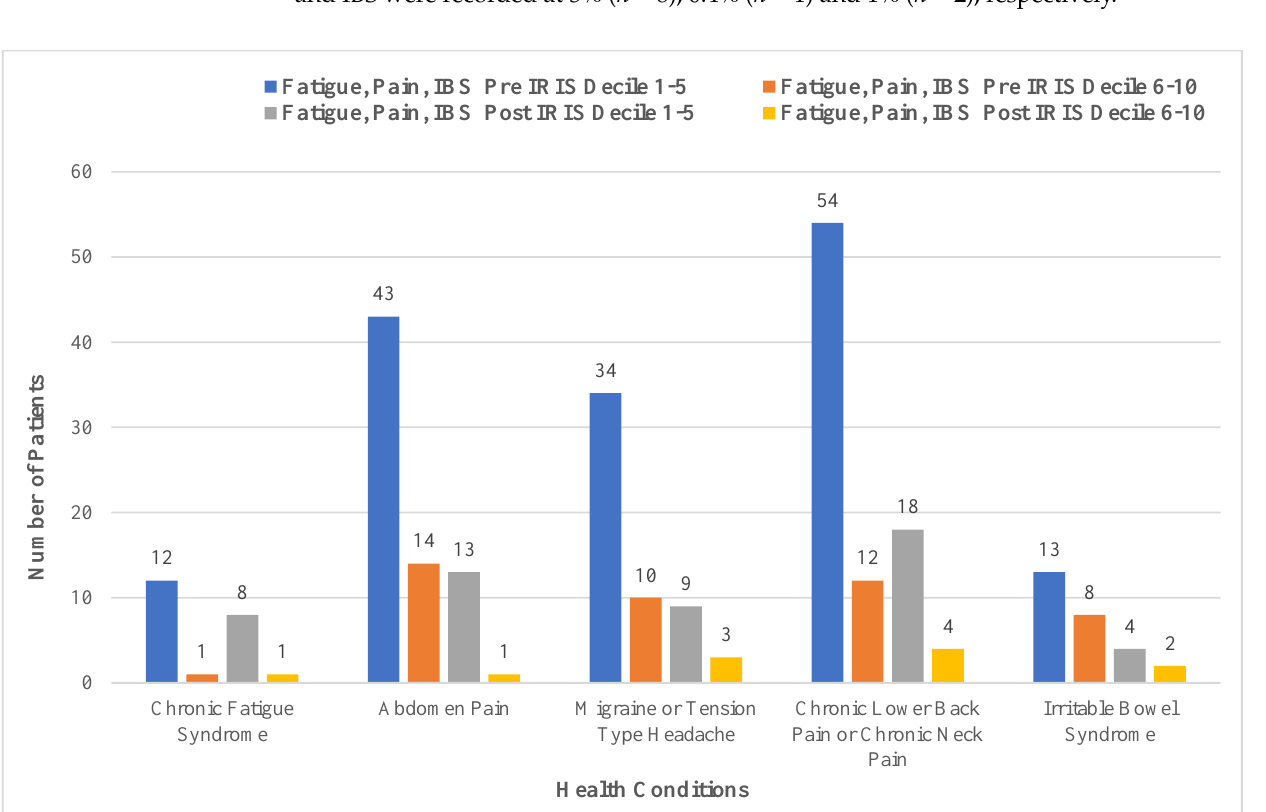
Figure 6. Comparison of fatigue, pain and irritable bowel syndrome and deprivation decile ( n = 250). In summary, the average number of health conditions per patient included in the study was 2.78 pre-IRIS, and post-IRIS, the average number of conditions per patient was 1.28. The statistical analysis included two-tailed t- tests, with a cut-off for significance of 0.05 used to reject the null hypothesis and the p -value obtained lower than 0.05. A Mann – Whitney U-test was also conducted where the U stat value is 73 and lower than the U critical value of 83, so the difference is significant, with both statistical tests confirming significance. This is based on aggregated results for the overall study area. The results indicate an overall improvement of mental health conditions collectively, as well as in those conditions associated with pain. Depression pre-IRIS was recorded at 59%, and post- IRIS, it was 33%; anxiety pre-IRIS was recorded at 44%, and post-IRIS, it was 28%, suicidal